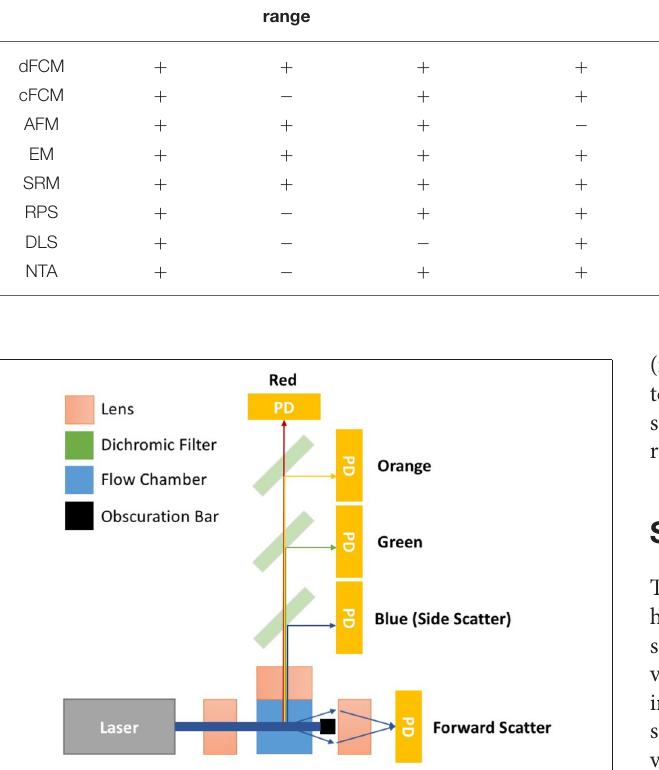
FIGURE 1 | Simplified flow cytometer layout. The top down view of the flow cytometry components depicts a monochromatic interrogation laser beam traversing through air before being focussed by a lens onto the silica flow chamber. Within the flow chamber is a hydrodynamically focussed core stream. The illuminated region of the core stream, where particles are passed through the beam, is known as the interrogation zone. Light scattered from the particles is sent in all directions. The light scattered perpendicular to the laser beam is focussed onto detectors by an optically coupled collection lens. This light then travel through a series of filters to split the light wavelength before reaching a photon detector (PD). PDs will convert photons to electrical signals will be sent to a digital acquisition (DAQ) board for further analysis. The forward scattered light is collected from around the obscuration bar, which stops the laser beam light saturating the forward scatter detector. Points 1–4 outline some of the changes to conventional flow cytometry that would create a dedicated small particle flow cytometer. (1) Lasers—high powered lasers, with a smaller focussed beam spot size, (2) Fluidics—a stable slow velocity core stream, that has a small diameter (1–2 µ m), (3) Fluorescence/Side scatter optics—smaller fluorescence/side scatter collection optical apertures and/or higher sensitivity detectors e.g., avalanche photodiodes, (4) Forward scatter optics—larger forward scatter obscuration bars and higher